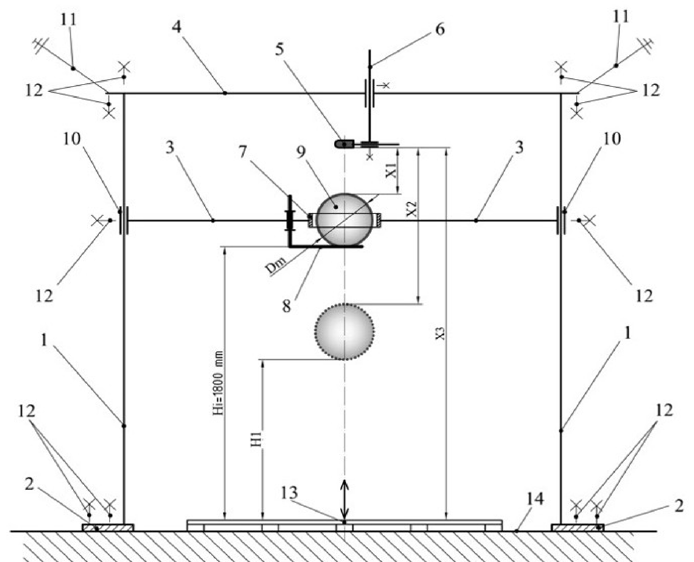
Figure 3. Sketch of the basketball ball reaction test stand: 1—support poles; 2—base plate for column; 3—metal ring supporting beam; 4—grid for the ultrasound device; 5—ultrasound device; 6—ultrasonic device fixing rod; 7—metal flat ring for the ball; 8—ball height diameter; 9—basketball; 10—lower beam clamping element; 11—ceiling fixing cable; 12—fixing screws; 13—carpet of beech wood friezes; 14—concrete support for tested panel.